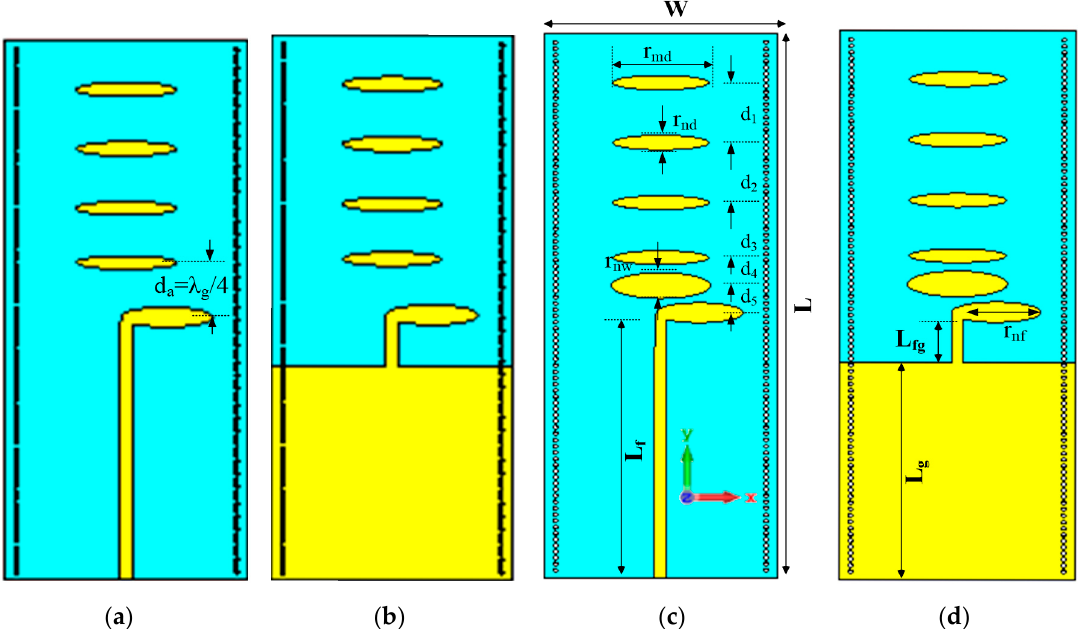
Figure 1. Layout diagram of the Yagi antenna ( a , b ), with first directive element at λ g /4 and geometric parameters of the proposed antenna design ( c , d ), with tightly coupled directive element.